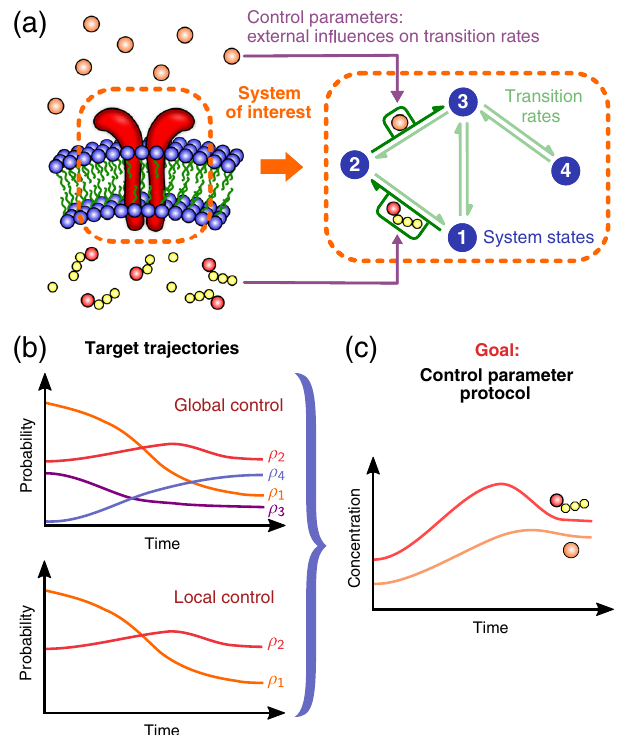
FIG. 1. Schematic ofthe biological control problem. (a) A system of interest (here a membrane receptor protein) is described via a networkoftransitionratesbetweendiscretestates.Certainratesmay be influenced by factors external to the system, which we denote as control parameters. For biochemical systems these are often concentrations of chemical species (ligands, ATP, etc.) or environ- mental factors like temperature. (b) We consider two types of control: global control , where we require the probability of every state to follow a target trajectory over a finite time interval, and local control , where we impose this requirement on only a subset of states.(c)Ineithercase,thegoalistofindwhethercontrolispossible for a given target, and if so calculate the control parameter protocol that forces the system to follow the target